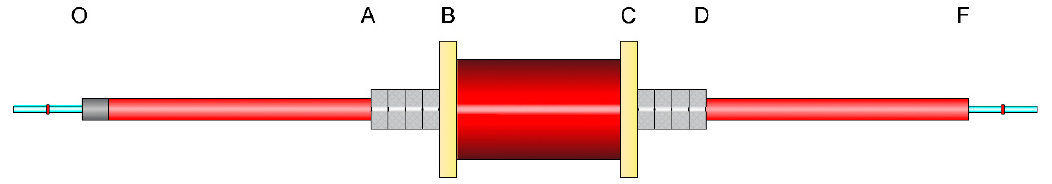
Figure 4. Set up for traction tests on composite and single bars in the laboratory: the segments OA and DF are free portions; portions AB and CD are nuts for fixing the bar to the jack; the central segment BC is the portion loaded with the jack.